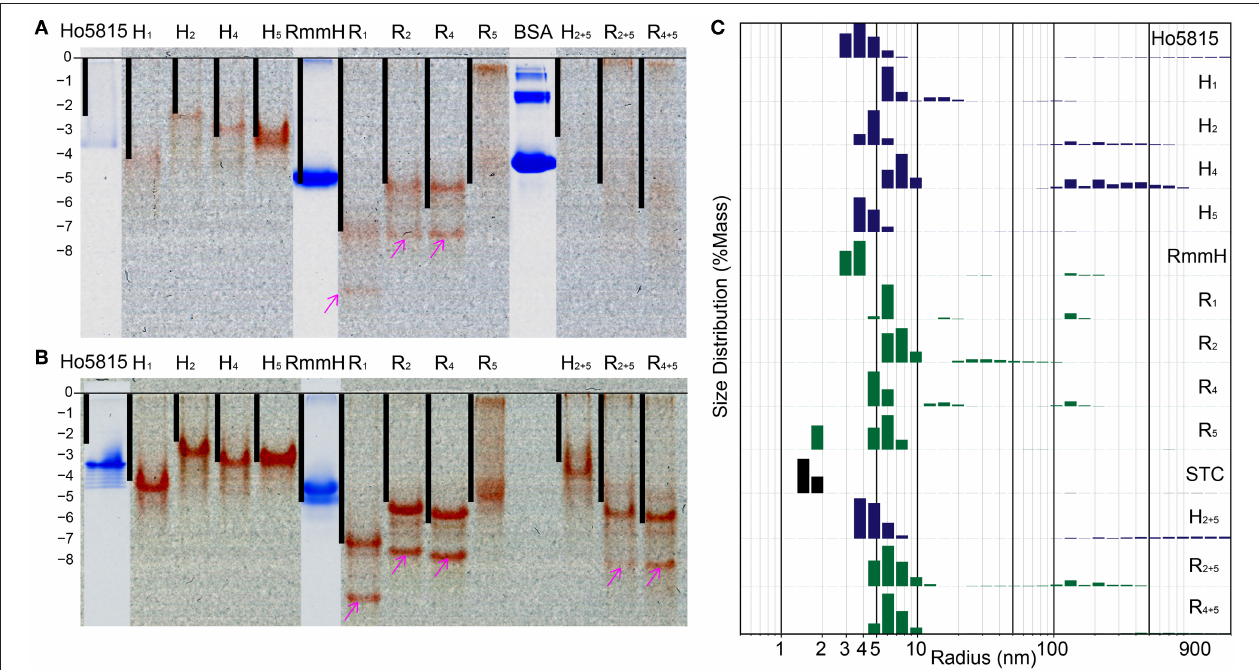
FIGURE 3 | Shell-cytochrome retain capacity to oligomerize. (A) Native PAGE (B) native PAGE with 4M urea show the mobility of H -/ R -variants and their corresponding WT. Lanes of H -/ R -variants show as un-stained and the red is the natural color of hemes. WT Ho-5815 and RmmH as well as molecule weight marker BSA were overlapped from the same gel after staining. The calculated net charge for shell-cytochrome monomers are plotted as black bars. The “0” charge is aligned to the beginning of resolving gel and the vertical length is stretched to allow RmmH to align to the gel band. (C) DLS of H -/ R -variants compare with corresponding WT and STC. The heights of bars represent the relative mass